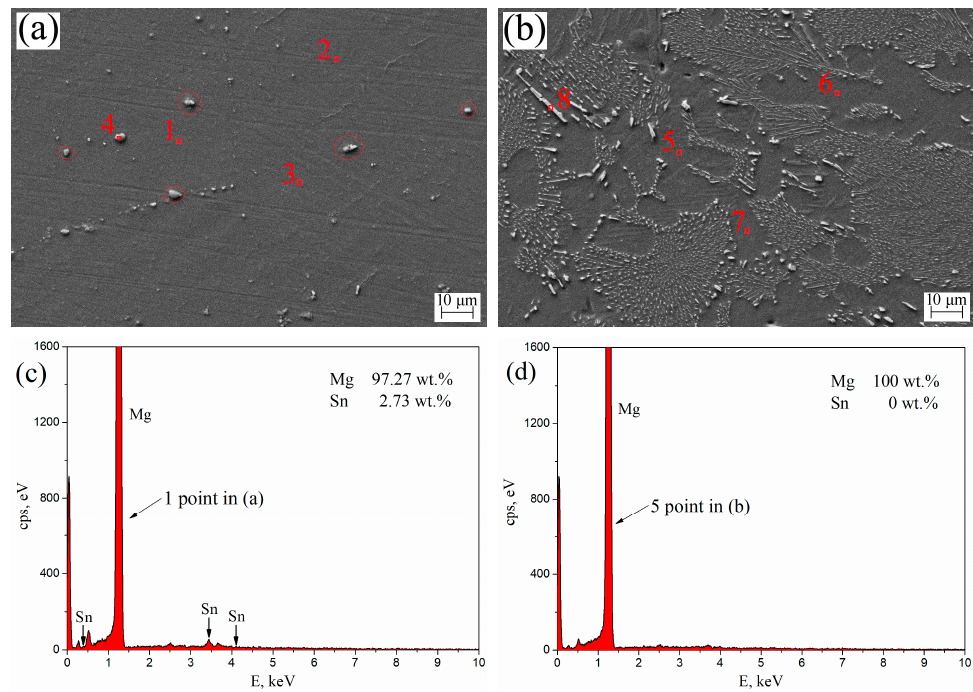
Figure 7. SEM morphologies of aged Mg-3Sn ( a ) and Mg-3Sn-1Ca ( b ) alloys for 7 h at 513 K; ( c ) EDS spectra 1 point in ( a ); ( d ) EDS spectra 5 point in ( b ). Table 3. Element contents of aged Mg-3Sn ( a ) and Mg-3Sn-1Ca ( b ) by EDS analysis in Figure 7. Element